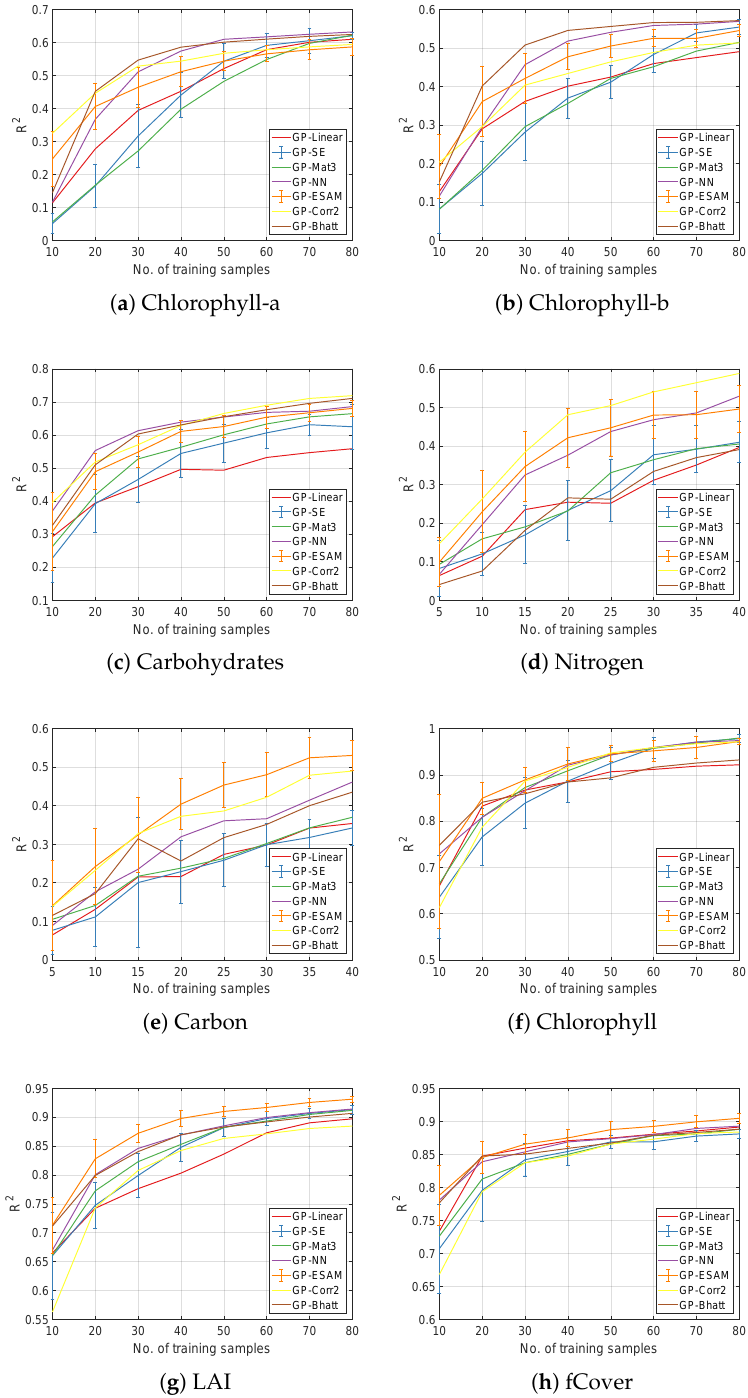
Figure 3. Performance as a function of training set size. ( a – c ) are from Algae dataset, ( d , e ) are from National Ecological Observatory Network (NEON) dataset, and ( f – h ) are from SPARC